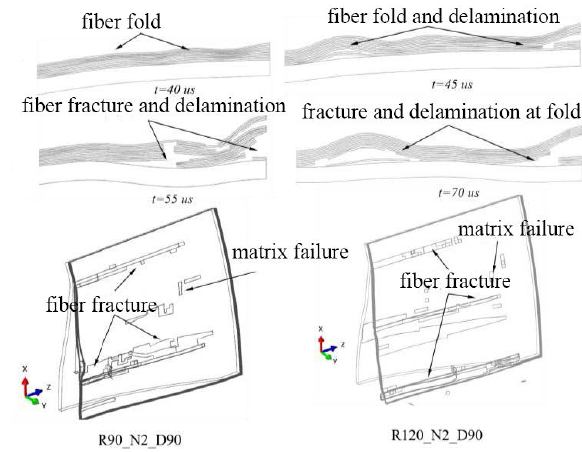
Figure 15. Failure mode of fiber with a large radius of curvature.